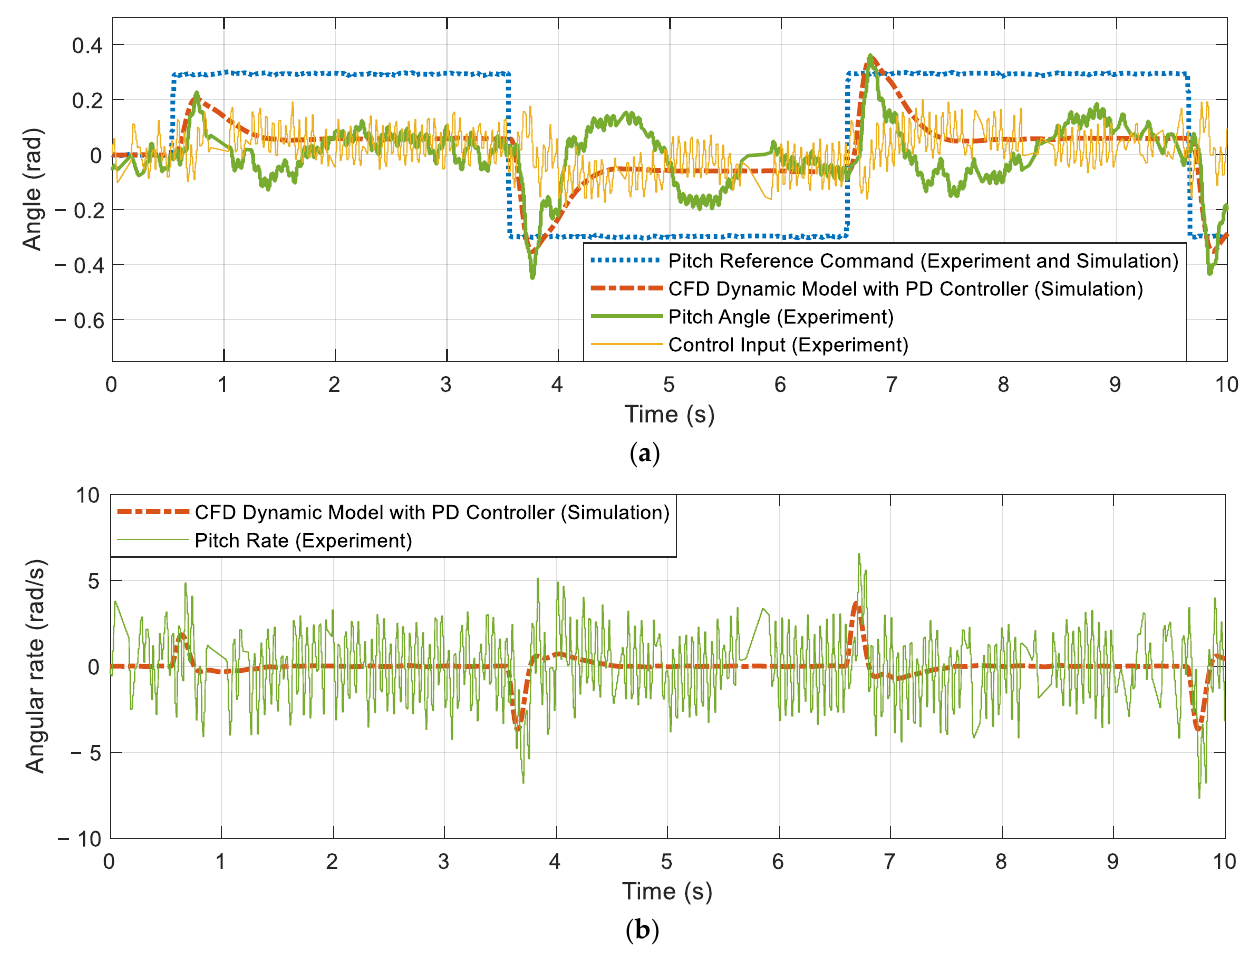
9 of 20 Figure 4. Frequency spectrum of reference commands. For clarity, the extended dynamic model with parameters obtained from CFD and force and moment measurements, later used as the initial dynamic model in system iden- tification, is called the CFD dynamic model. Figure 5 shows experimental and simulation results of the KUBeetle with a regular square command for pitch. Together with the pre- programmed command, the constant trim control input from the remote control was ap- plied to the KUBeetle. The constant trim command was subtracted to obtain the reference command from the actual command input applied. Small noises were added while the trim control input was being read from the pulse-width-modulated signal. The reference command was the summation of the preprogrammed command and the added trim com- mand noise. Figure 5a shows that the closed-loop KUBeetle has a relatively slow response, high overshoot, and large steady state error. After the reference command was provided, the KUBeetle attempted to follow the reference command in the beginning by responding quickly according to the stroke plane change via the servo motor. However, it was grad- ually stabilized to a low pitching angle, which maintained the large steady state error.